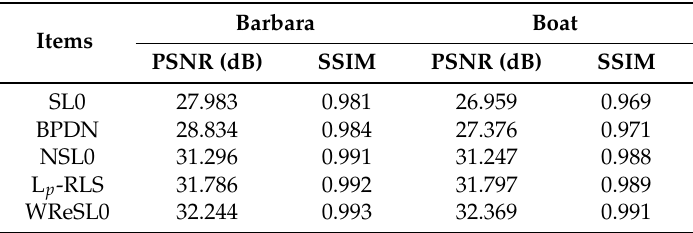
Figure 7. Image recovery effect by the BPDN, SL0, NSL0, L p -RLS, and WReSL0 algorithms with noise intensity δ N = 0.01. In ( a – d ), from left to right, are: image recovered by the BPDN, SL0, NSL0, L p -RLS, and WReSL0 algorithms. Table 3. PSNR and SSIM analysis of recovered images (boat and Barbara) by SL0, BPDN, NSL0, L p -RLS, and